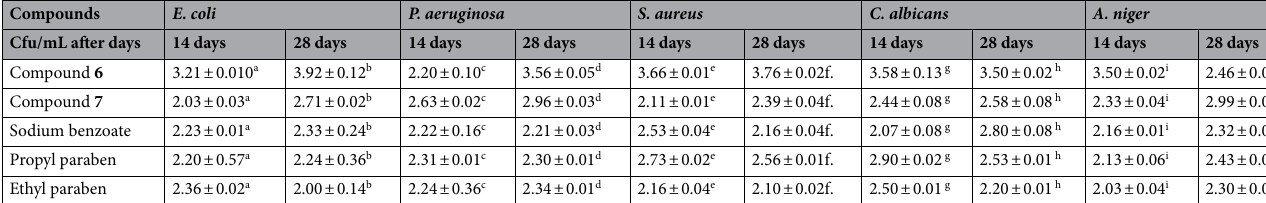
Table 4. Log CFU/ml values of the selected compound 7 and 6 in White lotion USP. Initial concentration of microbes in inoculum 1 × 10 5 –1 × 10 6 . CFU = Colony forming unit, all experiments were conducted in triplicate (n = 3) and the mean values are presented. Different letters mean p < 0.05 in each line by One-way ANOVA test.